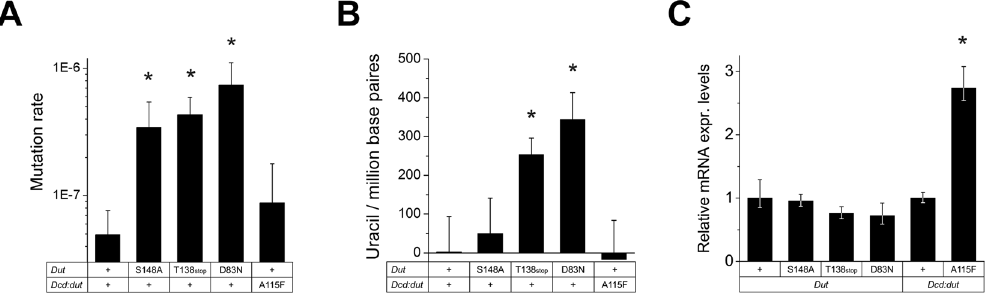
Figure 5. The effect of dut and dcd:dut mutations on the mutation rate, DNA uracilation and gene expression. ( A ) Mutation rates of mutant M. smegmatis strains. Means ± SE are calculated from (3 * 3) independent colonies from each mutation. Note that mutation rates of dut mutant strains directly correlate with the in vitro activity-loss of the corresponding mutant enzyme. Significance levels: P = 0.000115 for S148A, P = 0.000034 for T138stop and P = 0.000004 for D83N. “ + ” denotes the wt enzyme. ( B ) Genomic uracil content of the mutant strains compared to the wt strain. Uracil contents were calculated from three independent strains from each mutant and normalized to the wt strain; means ± SE are plotted. Note that the genomic uracil content of dut mutant strains directly correlates with the in vitro activity-loss of the corresponding mutant enzyme. Significance levels: P = 0.074 for T138stop, P = 0.018 for D83N. ( C ) Quantitation of dut and dcd:dut expression levels in the wt and mutant M. smegmatis strains. mRNA levels were calculated from three independent strains from each mutant and normalized to their respective wt strain; means ± SE are plotted. Significance level: P = 0.029 for the A115F